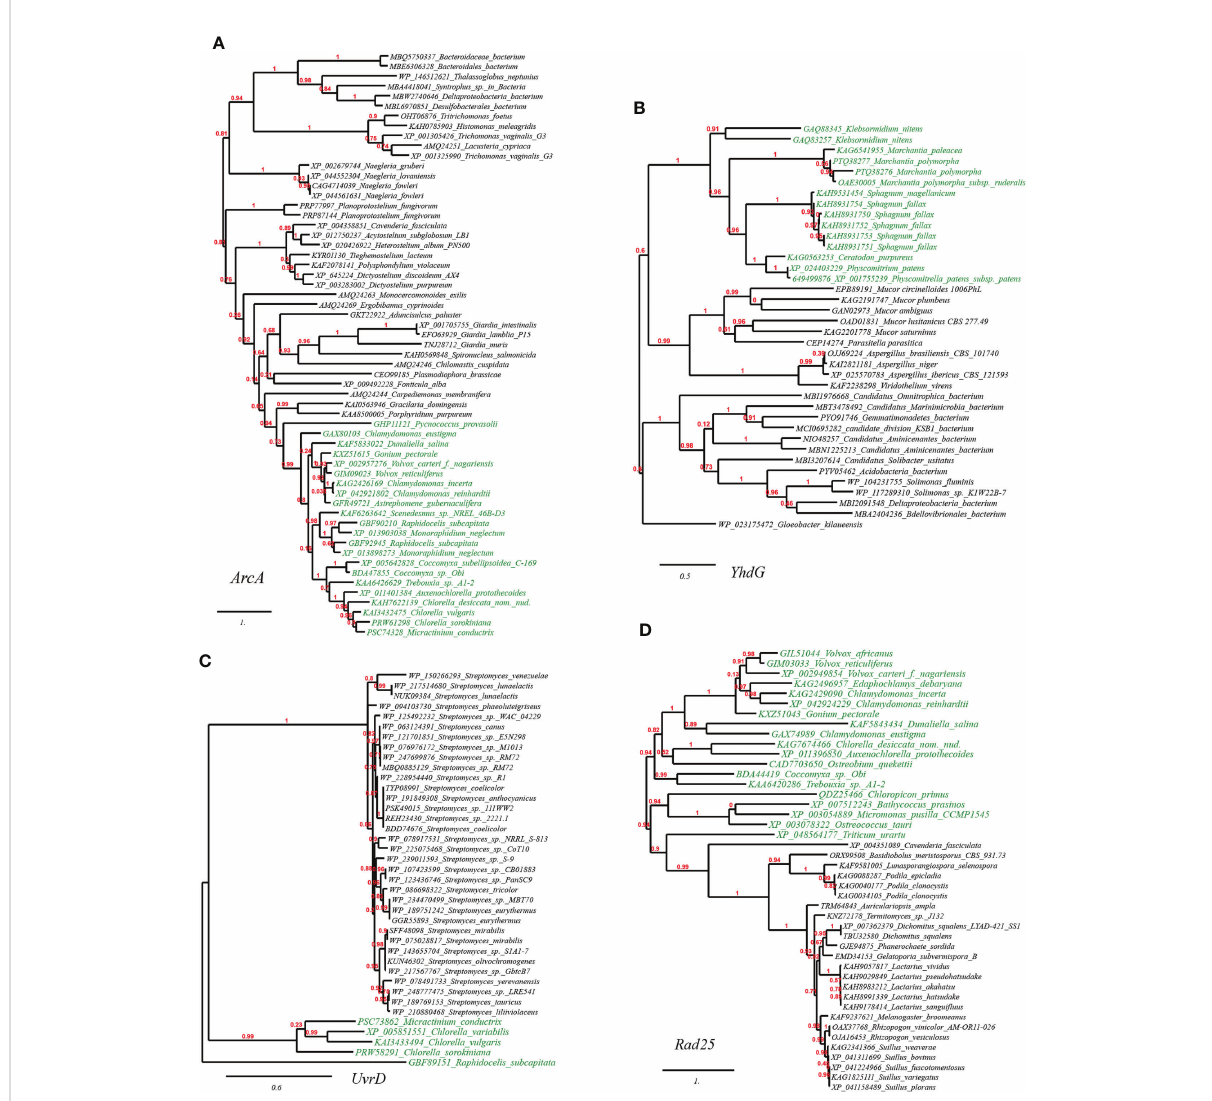
FIGURE 4 Phylogenetic tree of acid resistance and DNA damage resistance proteins in plant genomes originated from microbial taxa. The phylogeny construction was conducted based on gene-translating protein sequences using PhyML program with the Maximum Likelihood (ML) method and 1,000 bootstrap replicates (with bootstrap values in red showing on respective branches). Branches leading to plant taxa are marked by green color, whereas those belonging to microbial lineages are in black. (A) arginine deiminase (ArcA); (B) basic amino acid/polyamine